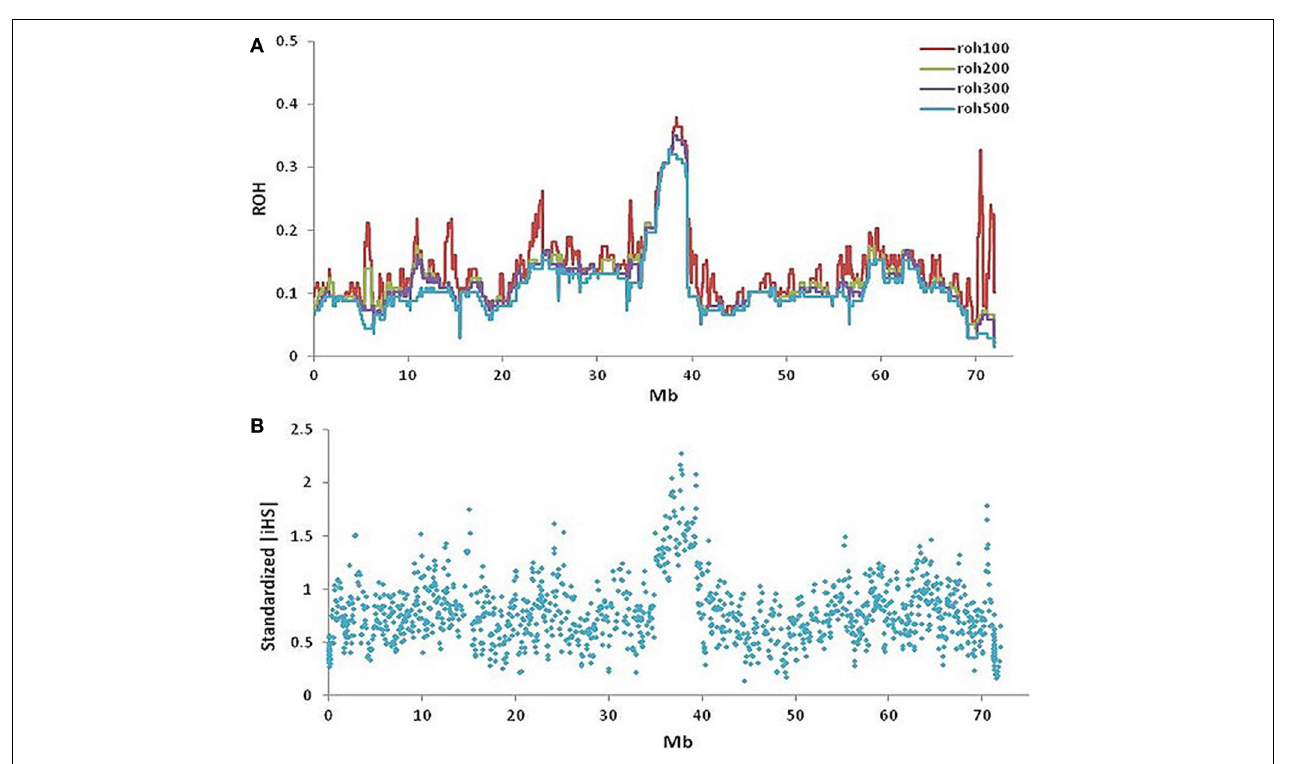
FIGURE 5 | Runs of homozygosity and signatures of selection on BTA20 within slick-haired animals. (A) Runs of homozygosity using windows of 100-red, 200-green, 300-purple, and 500-blue SNPs ( ∼ 0.3, 0.6, 1, 1.6Mb respectively) showed a peak value of 0.4 between 37.5 and 39.5Mb on